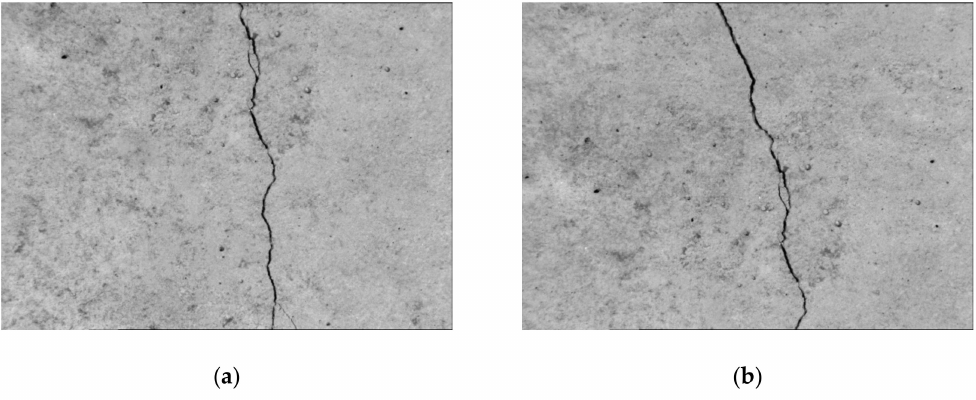
Figure 12. Image to be spliced: ( a ) left figure and ( b ) right